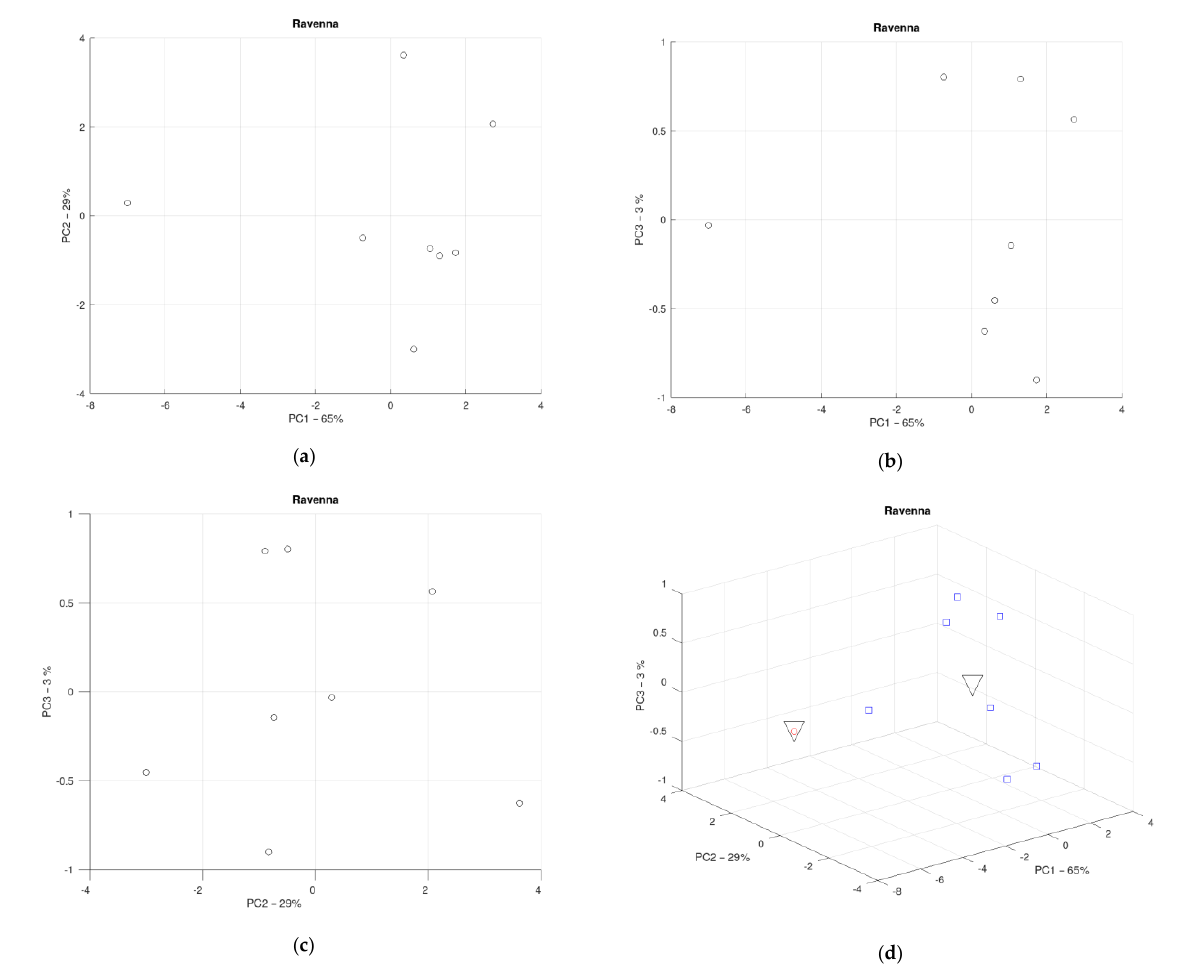
Figure 7. District of Ravenna 2D-Score plot showing PC1 vs. PC2 ( a ), PC1 vs. PC3 ( b ), PC2 vs. PC3 ( c ), and the 3D-score plot of the three principal components and clusters: first cluster in red, second cluster in blue, and the third cluster in green ( d ).